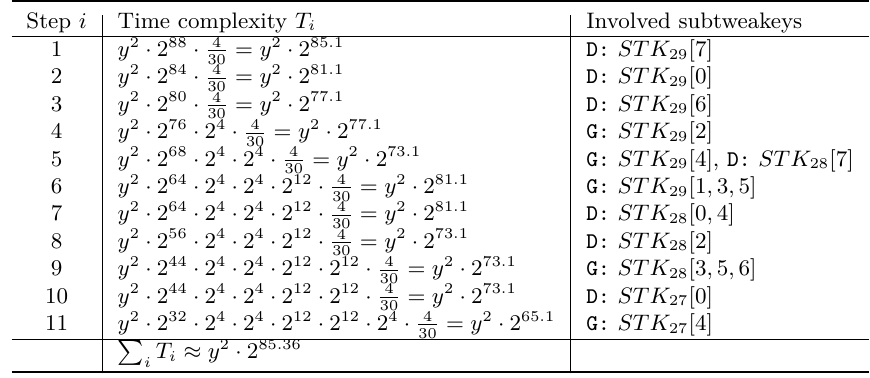
Table 8: Time complexity and guessed subtweakeys of each step in the tweakey recovery process for 30-round SKINNY-64-192 . D: deduced key cells; G: guessed key